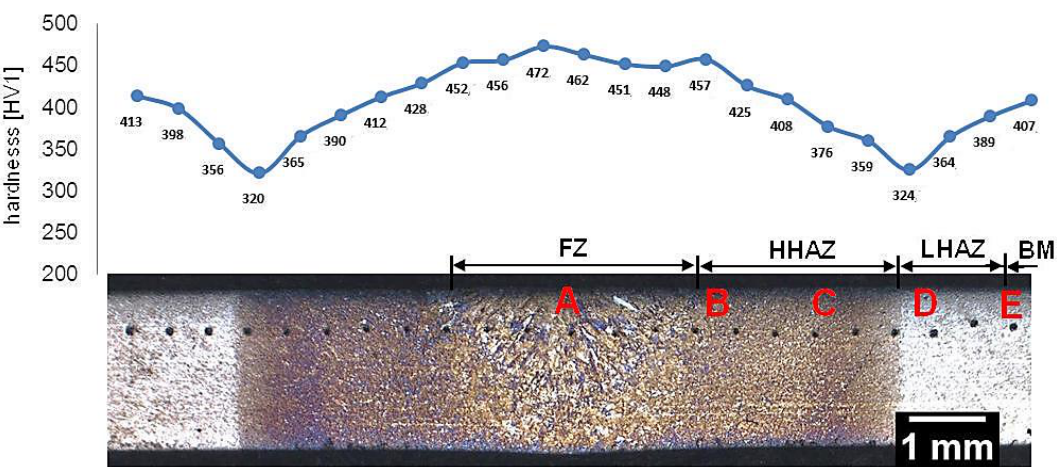
Figure 4. Macroscopic view of the welded joint of 55Si7 steel with regeneration along with the hardness distribution and areas of structural investigations. Etched by nital, LM.